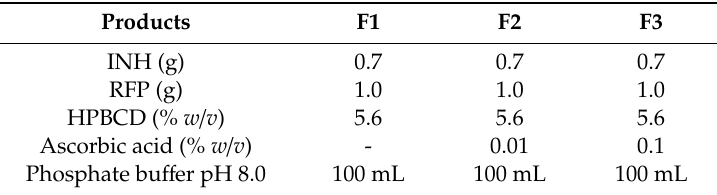
Table 1. Composition of every formulation studied. INH = Isoniazid; RFP = Rifampicin; HPBCD = hydroxypropyl- β